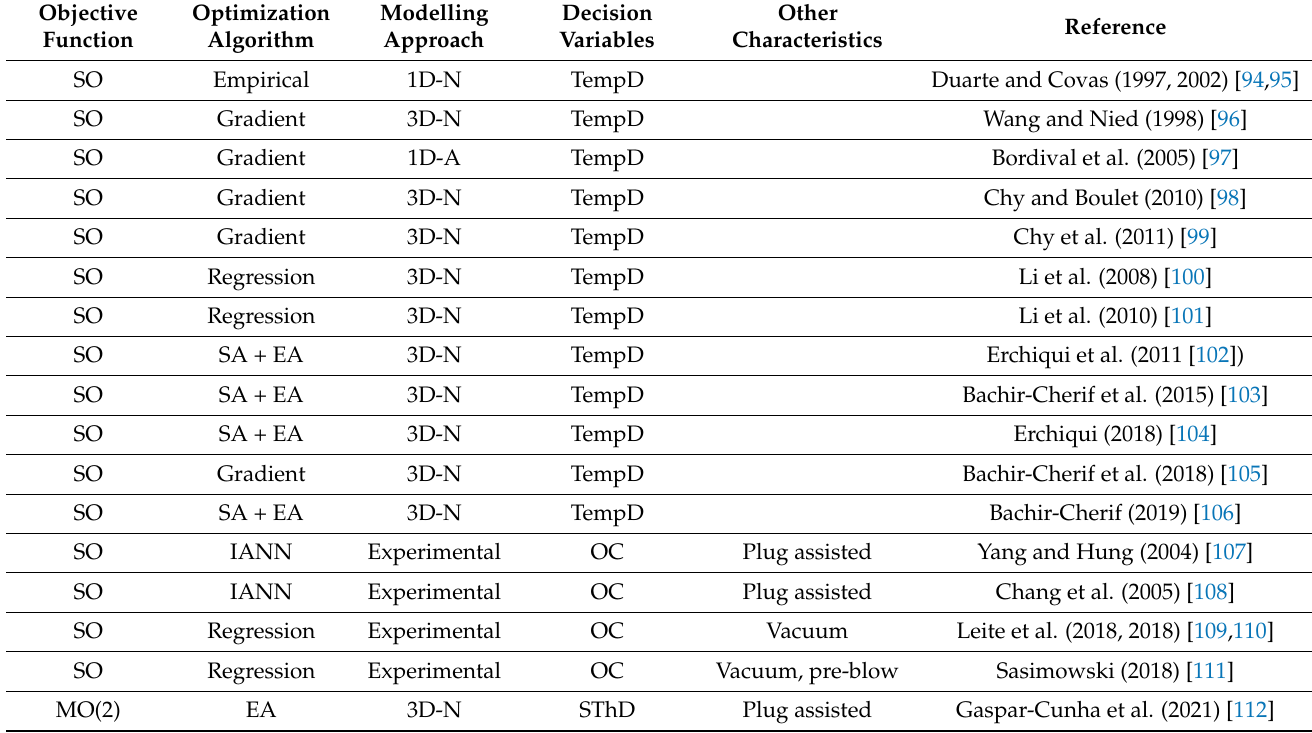
Previous publications on the optimization of thermoforming (decision